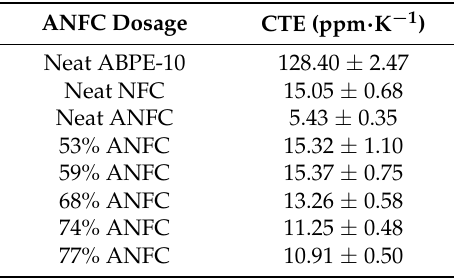
Table 2. The effects of different acetylated nanofibrillated cellulose (ANFC) dosages on the coefficient of thermal expansion (CTE) of different